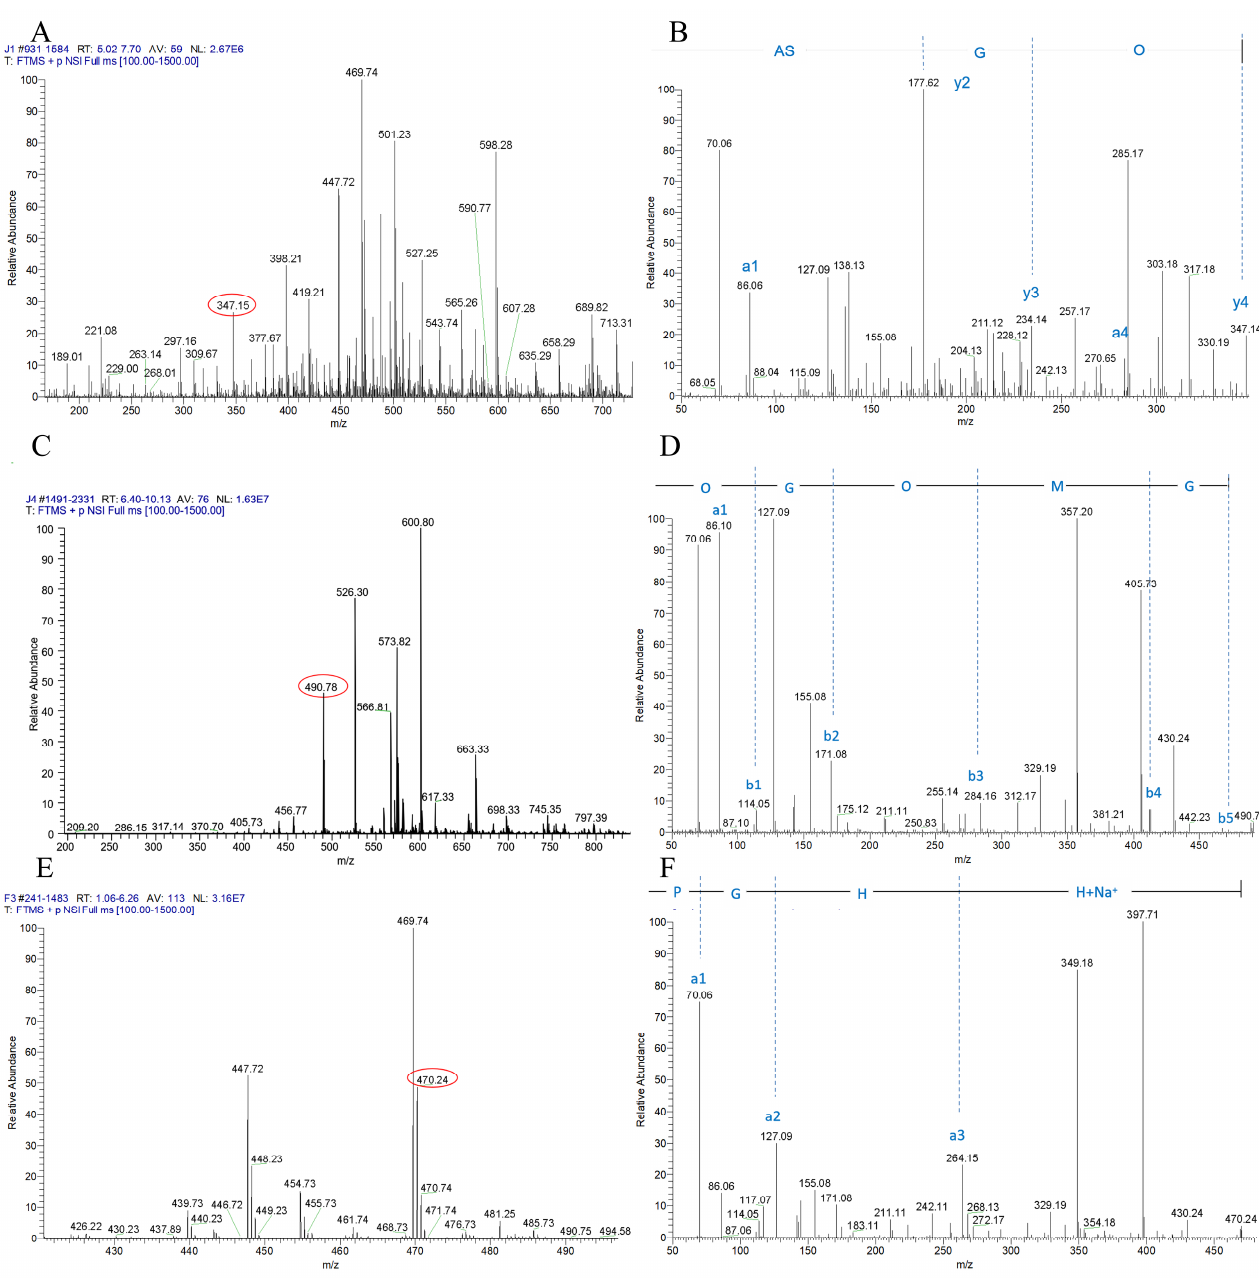
Figure 3. Identification of antiplatelet peptides from A1, A4, and P3. ( A ) Primary mass spectrum of A1. ( B ) Secondary mass spectrum of the peptide with m / z of 347.15. ( C ) Primary mass spectrum of A4. ( D ) Secondary mass spectrum of the peptide with m / z of 490.78. ( E ) Primary mass spectrum of P3. ( F ) Secondary mass spectrum of the peptide with m / z of